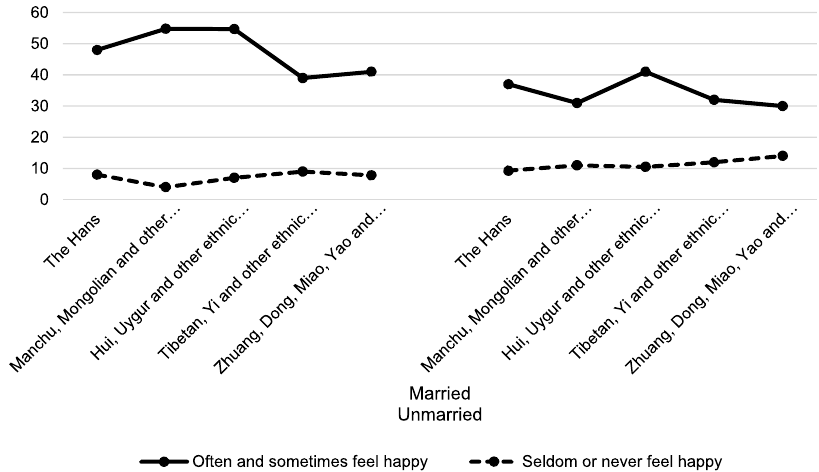
Fig. 5 Emotional integration and subjective well-being of ethnic groups